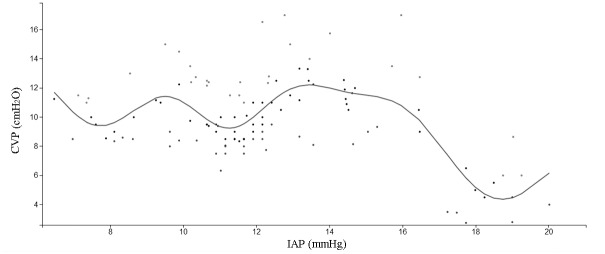
Scatter plot and smoothing curve of IAP (mmHg) by CVP (cmH2O).